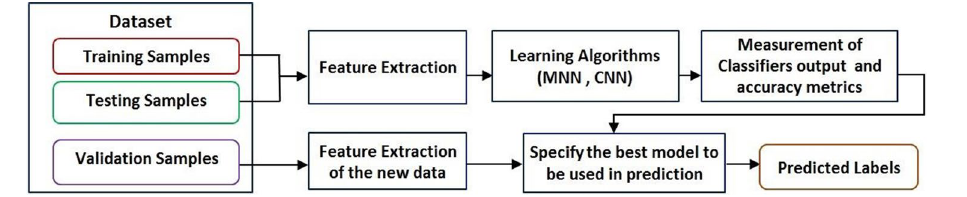
Figure 3. An inclusive flowchart for the proposed methodologies stages.